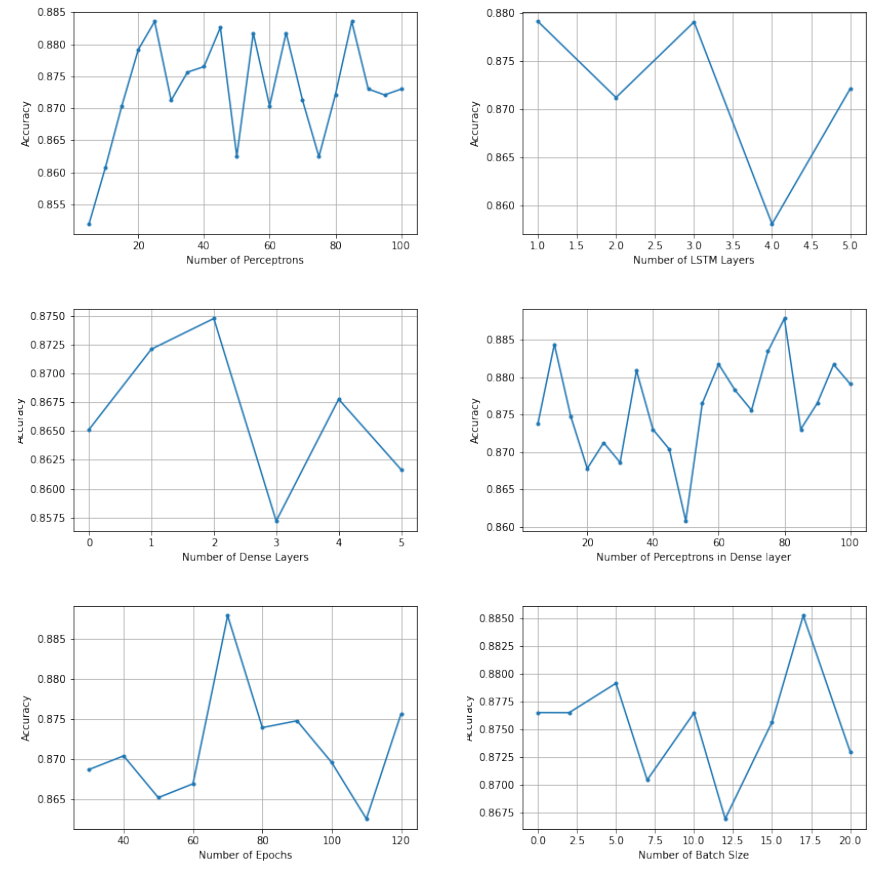
Figure 12. Exp2 LSTM Hyper Parameter Tuning.